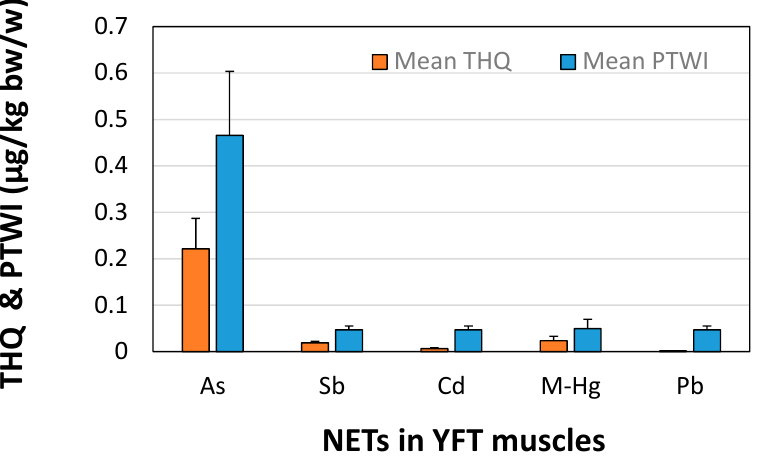
Figure 5. Target hazard quotient (THQ) and provisional tolerable weekly intake (PTWI) µ g/kg bw/w of consuming yellowfin tuna (YFT, T. albacares ). NETs: Non-essential toxic elements.